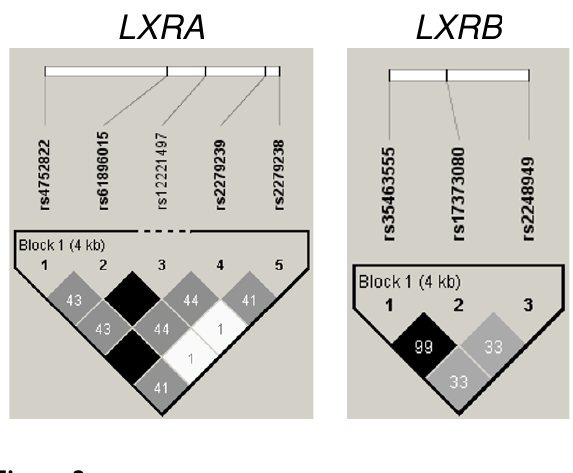
Table 3: Analysis of LXR haplotypes in T2D in the French cohort